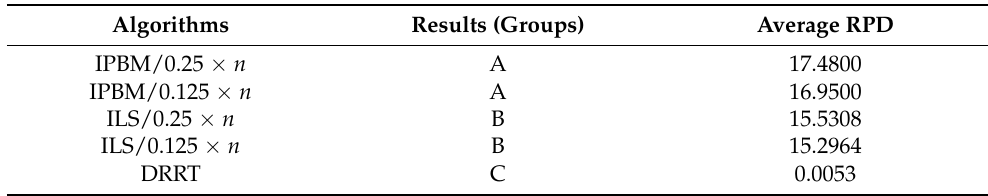
Table 3. Results of Duncan’s multiple range test for initial solution generator and algorithms with different termination conditions ( α = 0.01).